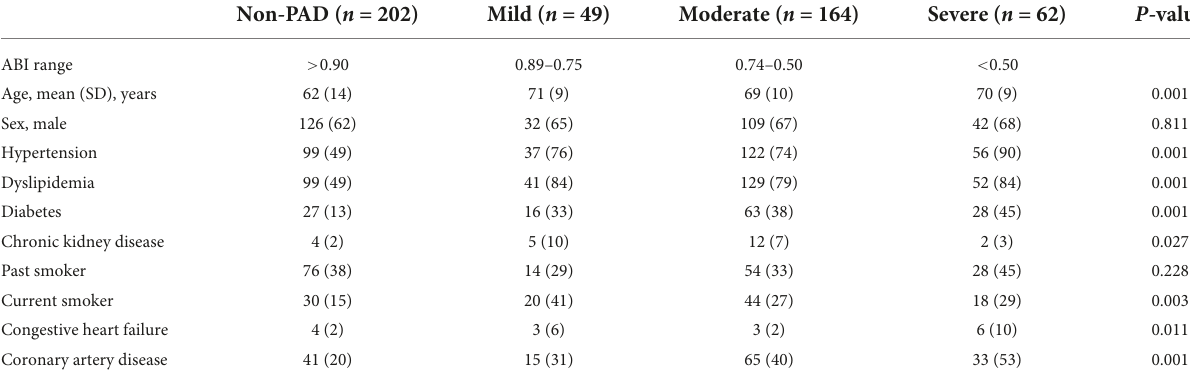
TABLE 1 Baseline demographic and clinical characteristics.